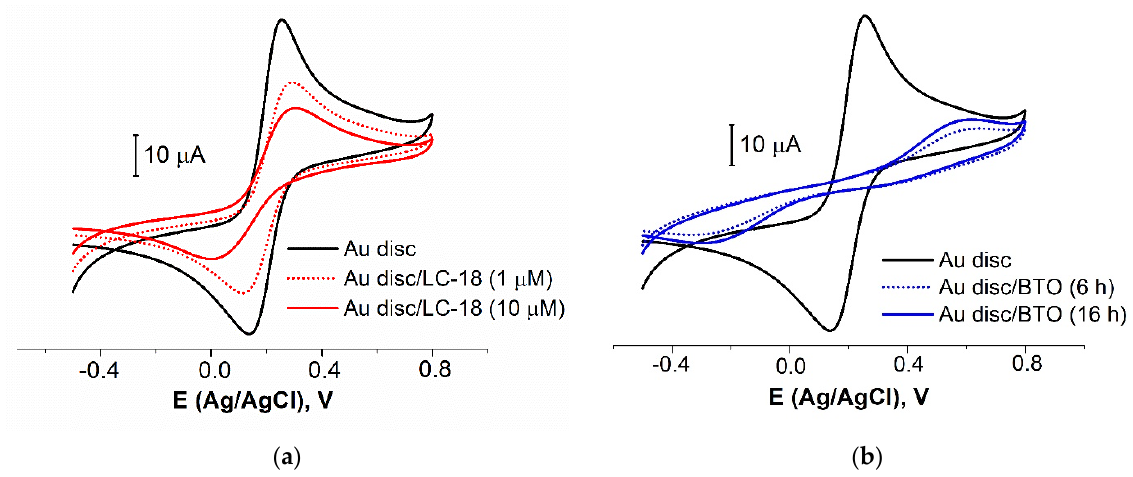
Figure 3. CVs for bare Au disc electrode and electrodes with LC-18 aptamer layer obtained from the solutions of different concentrations ( a ) and BTO layer obtained for different immobilization time ( b ). Solution: 0.025 M K 3/4 [Fe(CN) 6 ] in PBS (7.4). Table 3. Surface coverage of the gold electrode with LC-18 and BTO under varying concentrations or immobilization times.